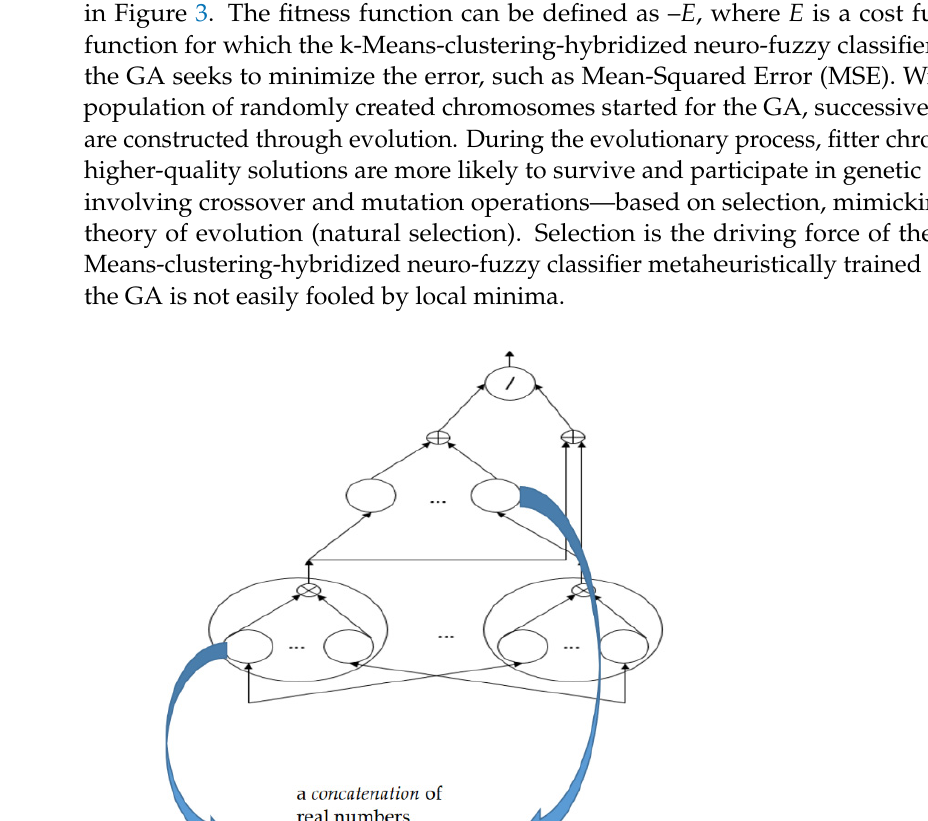
Figure 4. Flowchart of the computational routines involved for fitness evaluation of the parallel GA used to evolve the k- Means-clustering-hybridized neuro-fuzzy classifier for energy decomposition in this research. In the GA accelerated via parallel computing, a selection strategy that breeds a new population/generation is adopted, where fitness scaling may be needed. Besides this, a crossover operator is used to combine selected chromosomes as parents producing off- spring for the next population in the next generation of the evolutionary process. New offspring—new solutions—can be created to keep the population diversity high; these typically share many of the characteristics of the parents. Moreover, a mutation operator